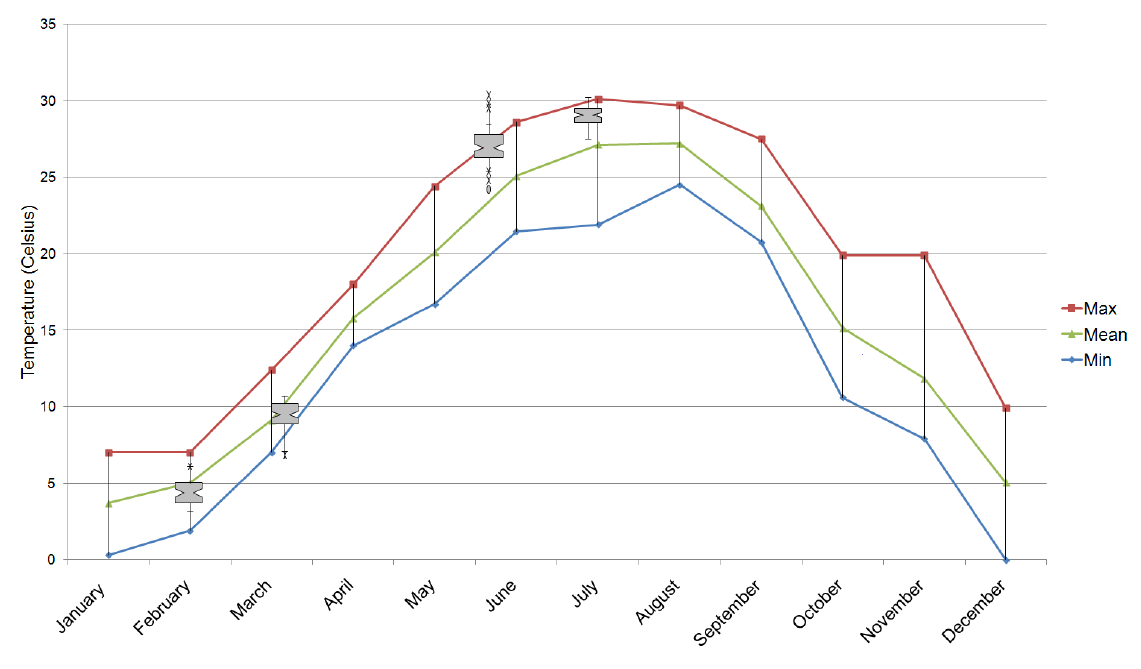
Figure 7. Box plots of ASTER-derived skin surface temperatures for flood repletion water mass (box plots) with line plots of in situ mean, minimum, and maximum monthly 2001–2011 water temperatures for Chincoteague (Maryland Department of Natural Resources, “Eyes on the Bay” http://mddnr.chesapeakebay.net/eyesonthebay/